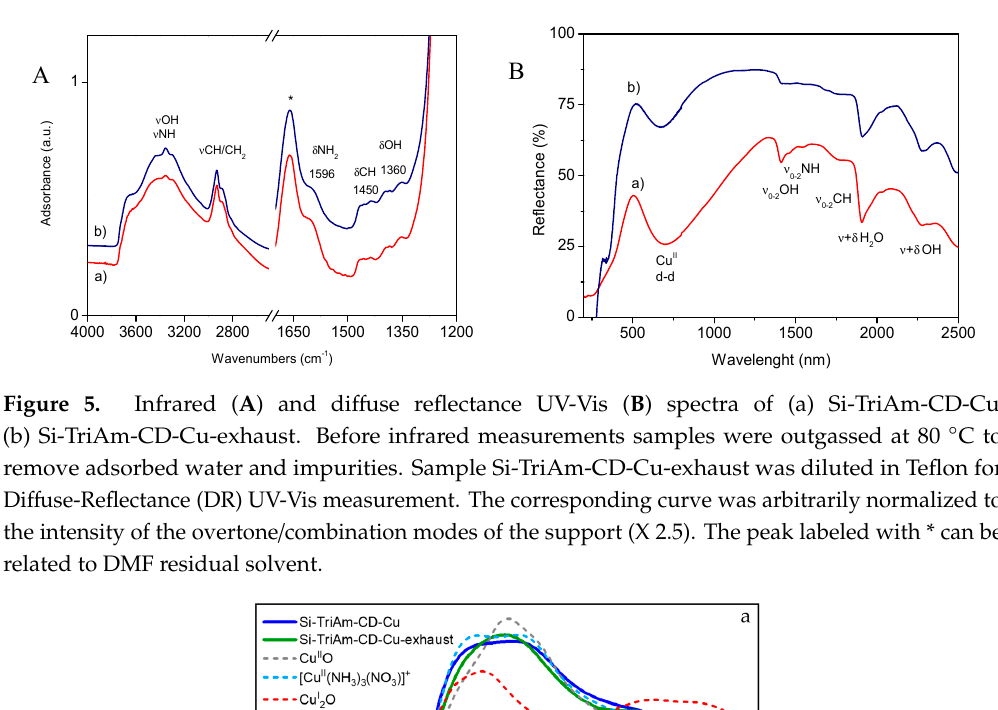
Figure 4. Recyclability of Si-TriAm-CD-Cu, compared to Si-DiAm-CD-Cu, in the CuAAC model reaction.